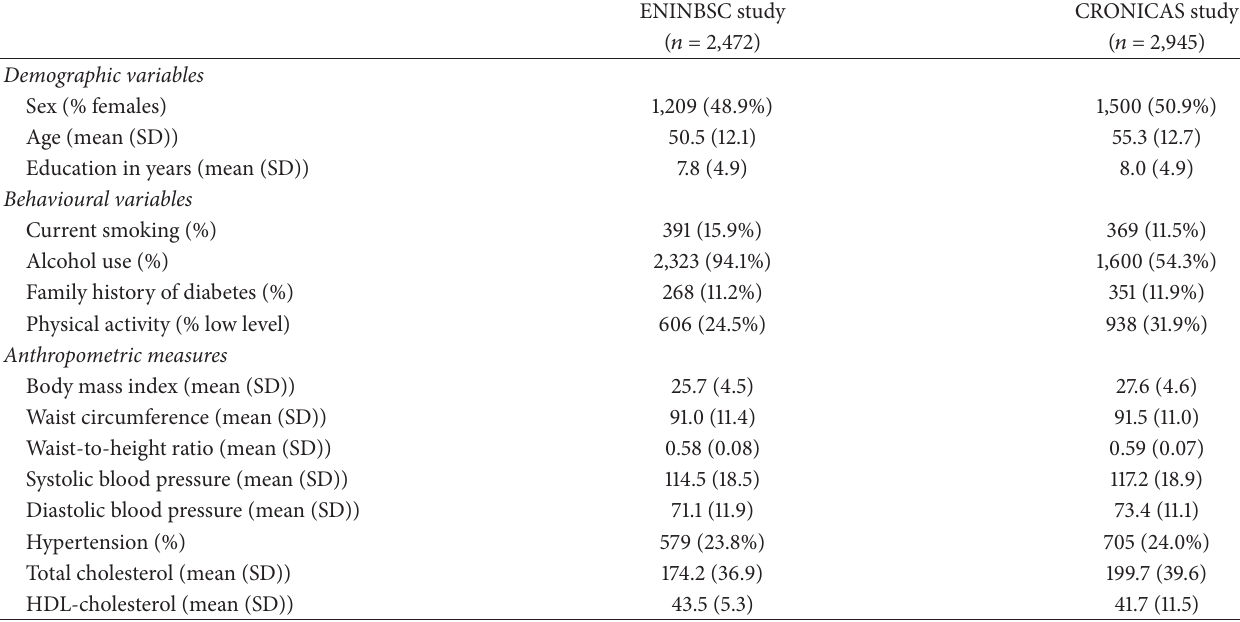
Table 1: Sociodemographic characteristics of participants without history of type 2 diabetes in the two involved studies.